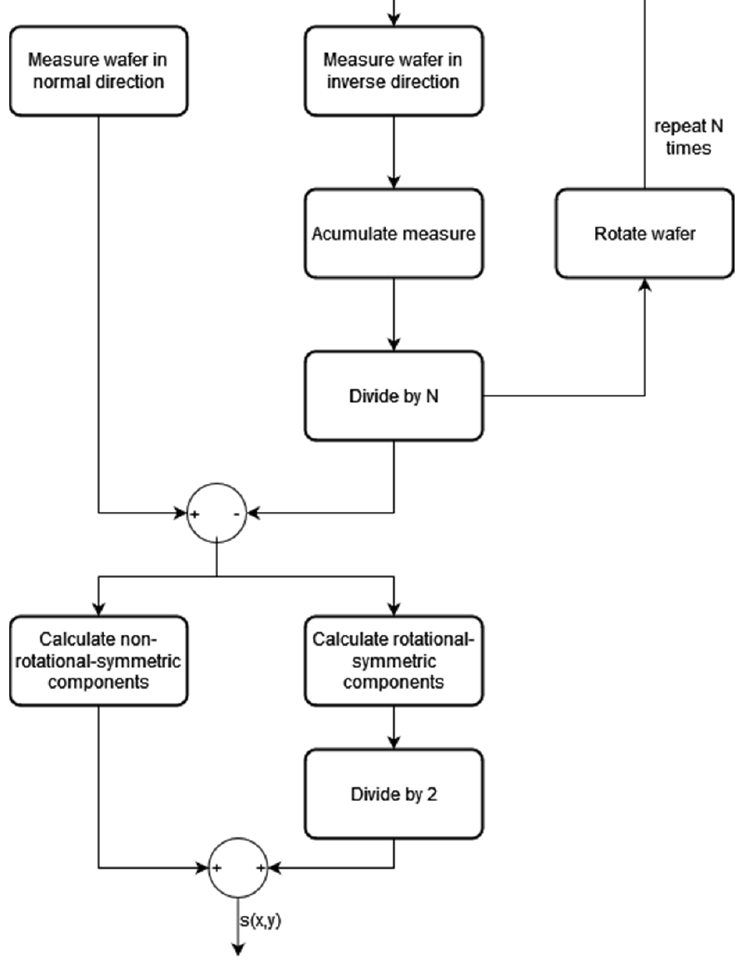
Figure 3. MGR method flowchart.